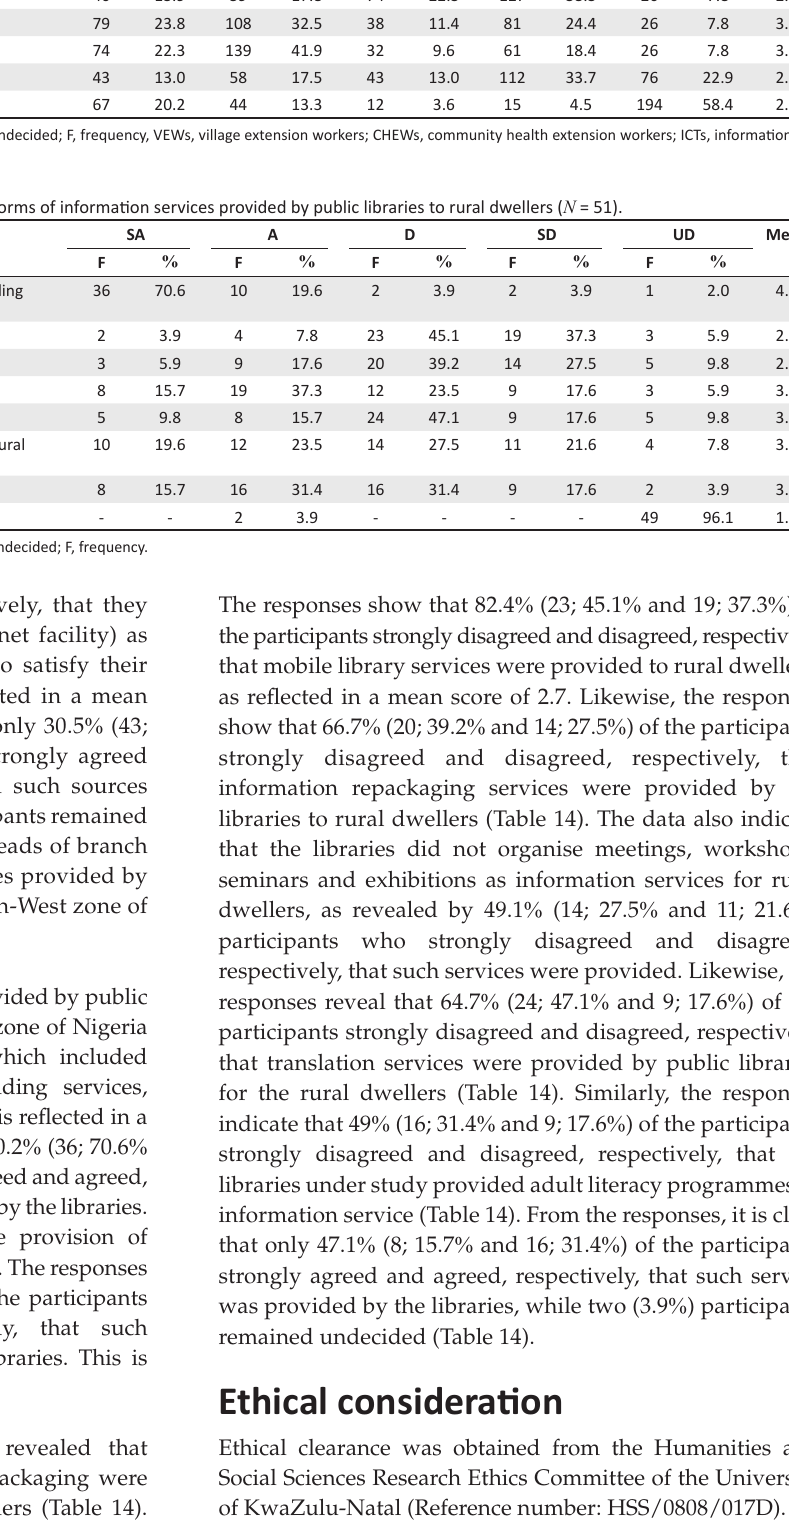
Town criers as a source from the library